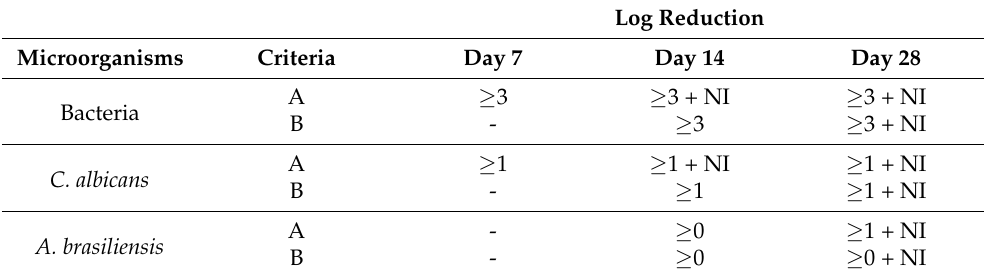
Table 4. Criteria according to ISO 11930 for assessing the microbial stability of a cosmetic product [17].